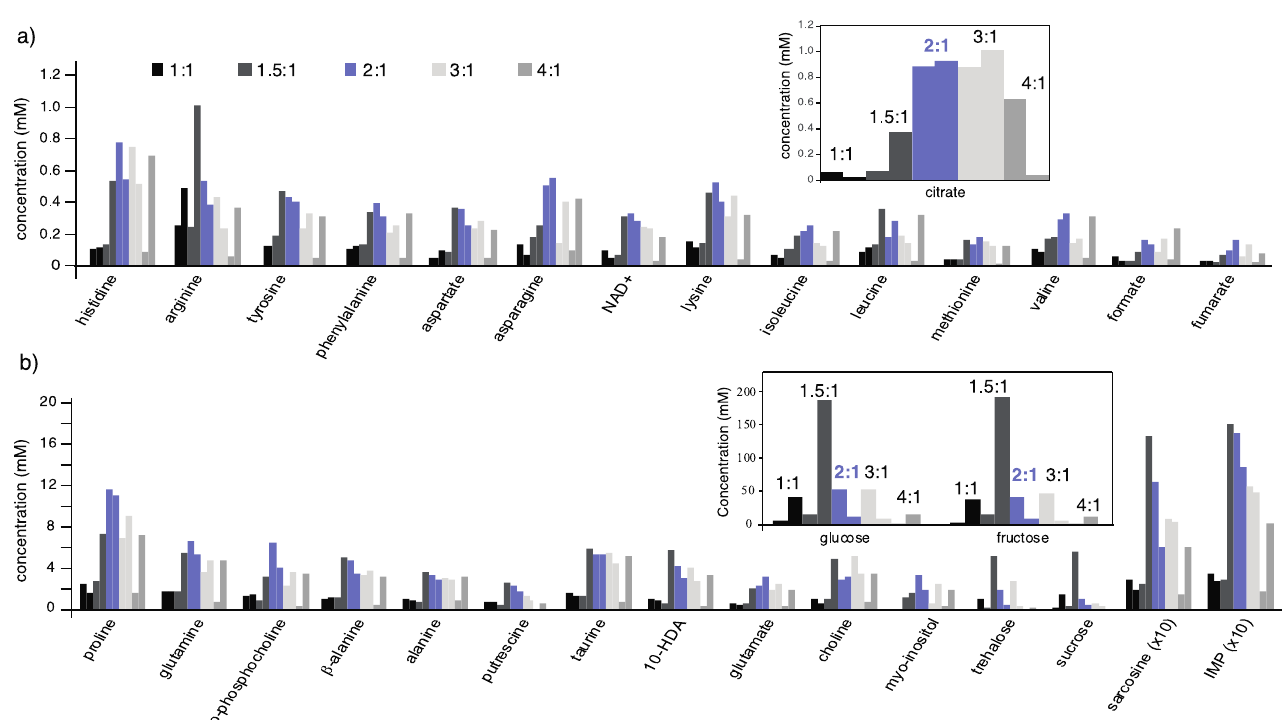
Figure 2. Concentrations of 32 metabolites obtained from the profiling of NMR spectra (pr-NOESY, 600 MHz, profiled with Chenomx 8.1 (Chenomx Inc., Edmonton, AB, Canada)) after the homogenization and extraction of single honeybees using different conditions. Data are shown for two bees in each of the following acetonitrile:water ratios: 1:1 (black), 1.5:1 (dark grey), 2:1 (blue), 3:1 (off-white), and 4:1 (light grey). Metabolites were grouped by relative concentrations: ( a ) relatively low concentrations, where the inset illustrates the data for a representative metabolite, and ( b ) intermediate concentrations, where the inset shows highly concentrated sugars. Note that the 2:1 ratio also decreased sucrose and trehalose in ( b ). The best overall recovery of metabolites was observed using the 2:1 acetonitrile to water ratio, although results with the 3:1 ratio were reasonably comparable. Spectra were acquired with 128 transients, 8 steady state scans, 13 s total delay (4 s acquisition and 9 s recovery), 2 s presaturation, and 100 ms NOESY mixing time. All bees are pollen foragers collected at the same time from one hive.